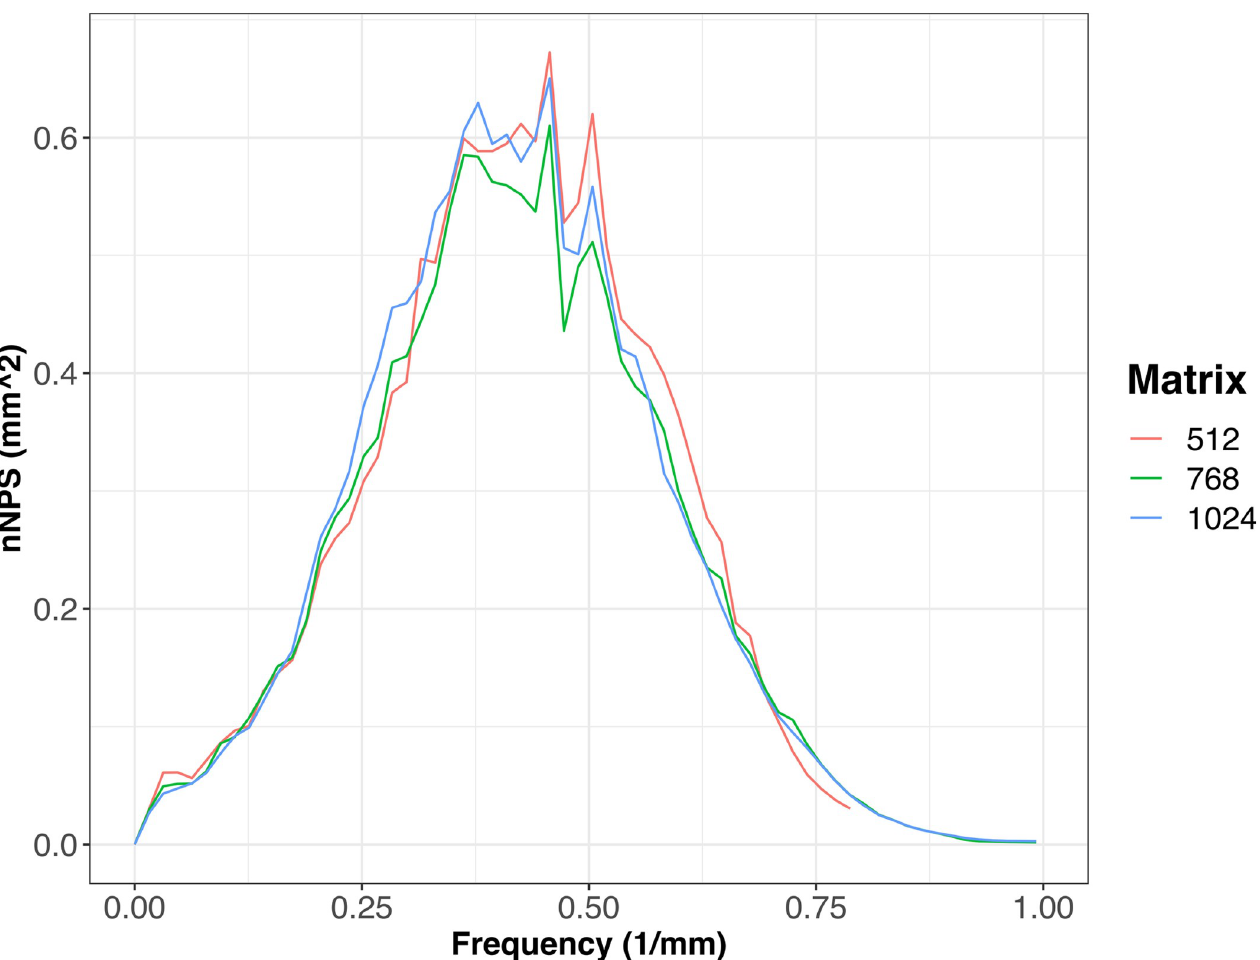
Fig 5. Comparison of noise texture. Graphs demonstrate similarity of the overall frequency content of the diagonal 1D profile of the 2D nNPS for each image matrix, indicating similar image noise texture.